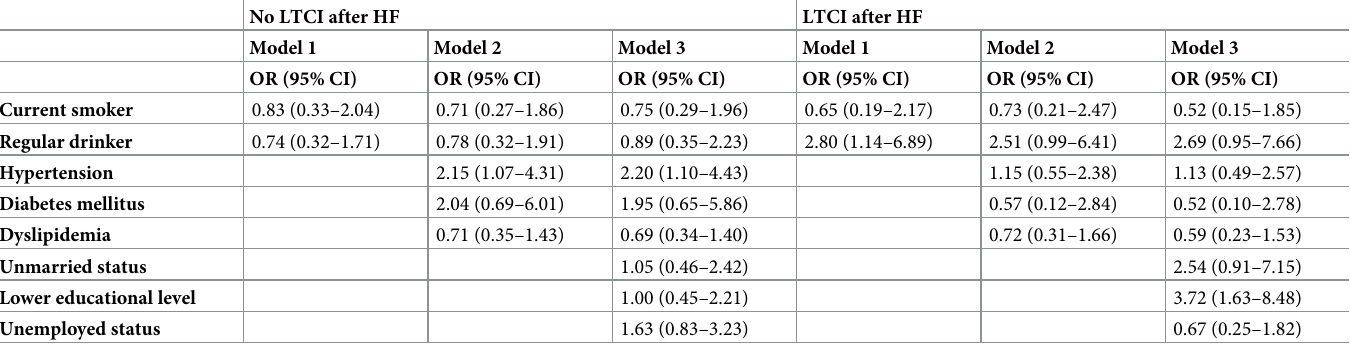
Table 2. Odds ratios for the categories of no long-term care insurance after heart failure and long-term care insurance after heart failure using conditional logistic regression analyses. No LTCI after